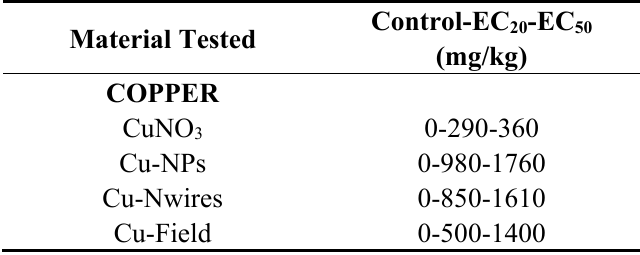
Table 2. Exposure concentrations (values in mg/kg) based on the reproduction